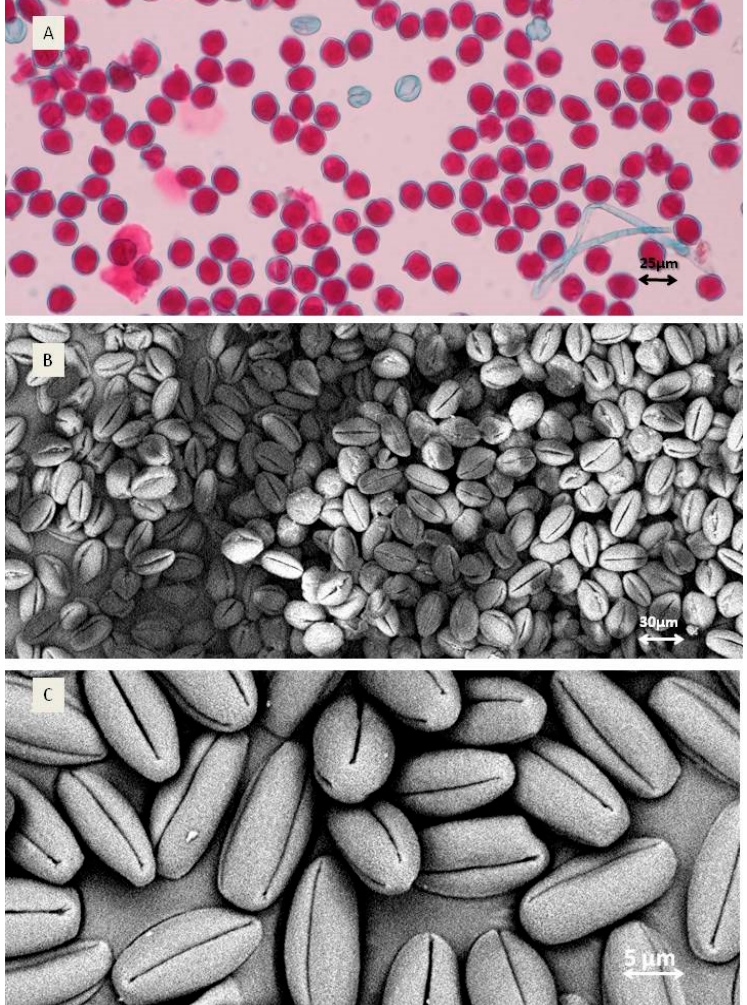
Figure 2. Pollen quality and shape. ( A ) Viability of A. arguta ‘Weiki’: red ‐ viable and non ‐ coloured— non ‐ viable pollen grains; ( B ) A. arguta ‘Rubi’ pollen grains; ( C ) shape of single A. arguta ‘Rubi’ pollen grain).